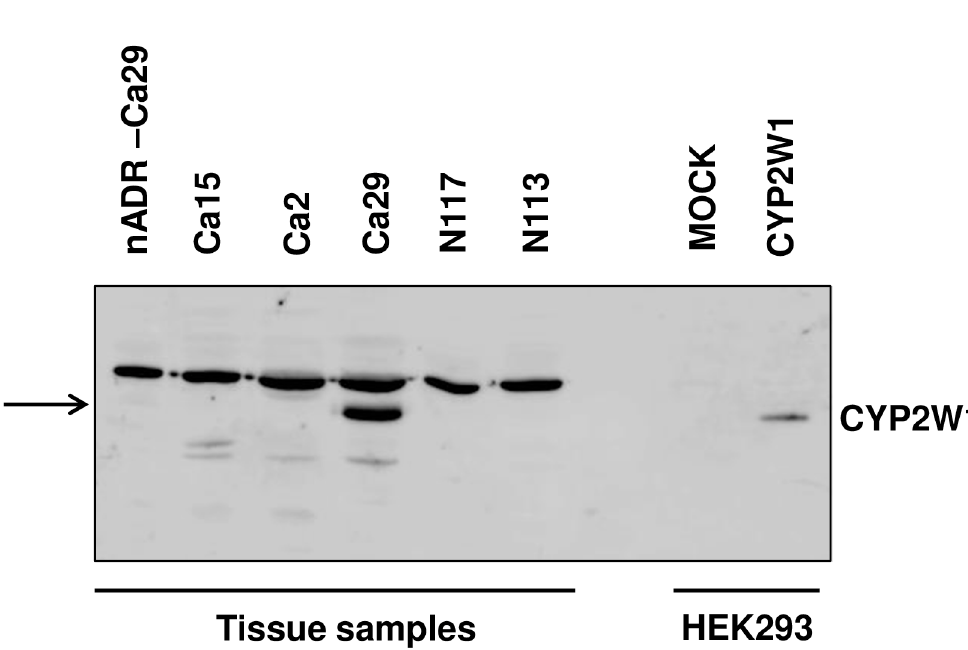
Fig 2. Western blot analysis of CYP2W1 expression in adrenocortical carcinoma (Ca) and normal adrenal cortex tissue (N) using the antibody 852 against a 15-residue sequence in the C-terminal end of the human CYP2W1 (Karlgren et al . 2006 [1]). A sample of HEK293 cells with stable expression of CYP2W1 was used as positive control and the corresponding Mock cells as negative control. nADR-Ca 29 represents normal adrenal cortex from the patient Ca 29. Arrow indicates the location of CYP2W1.